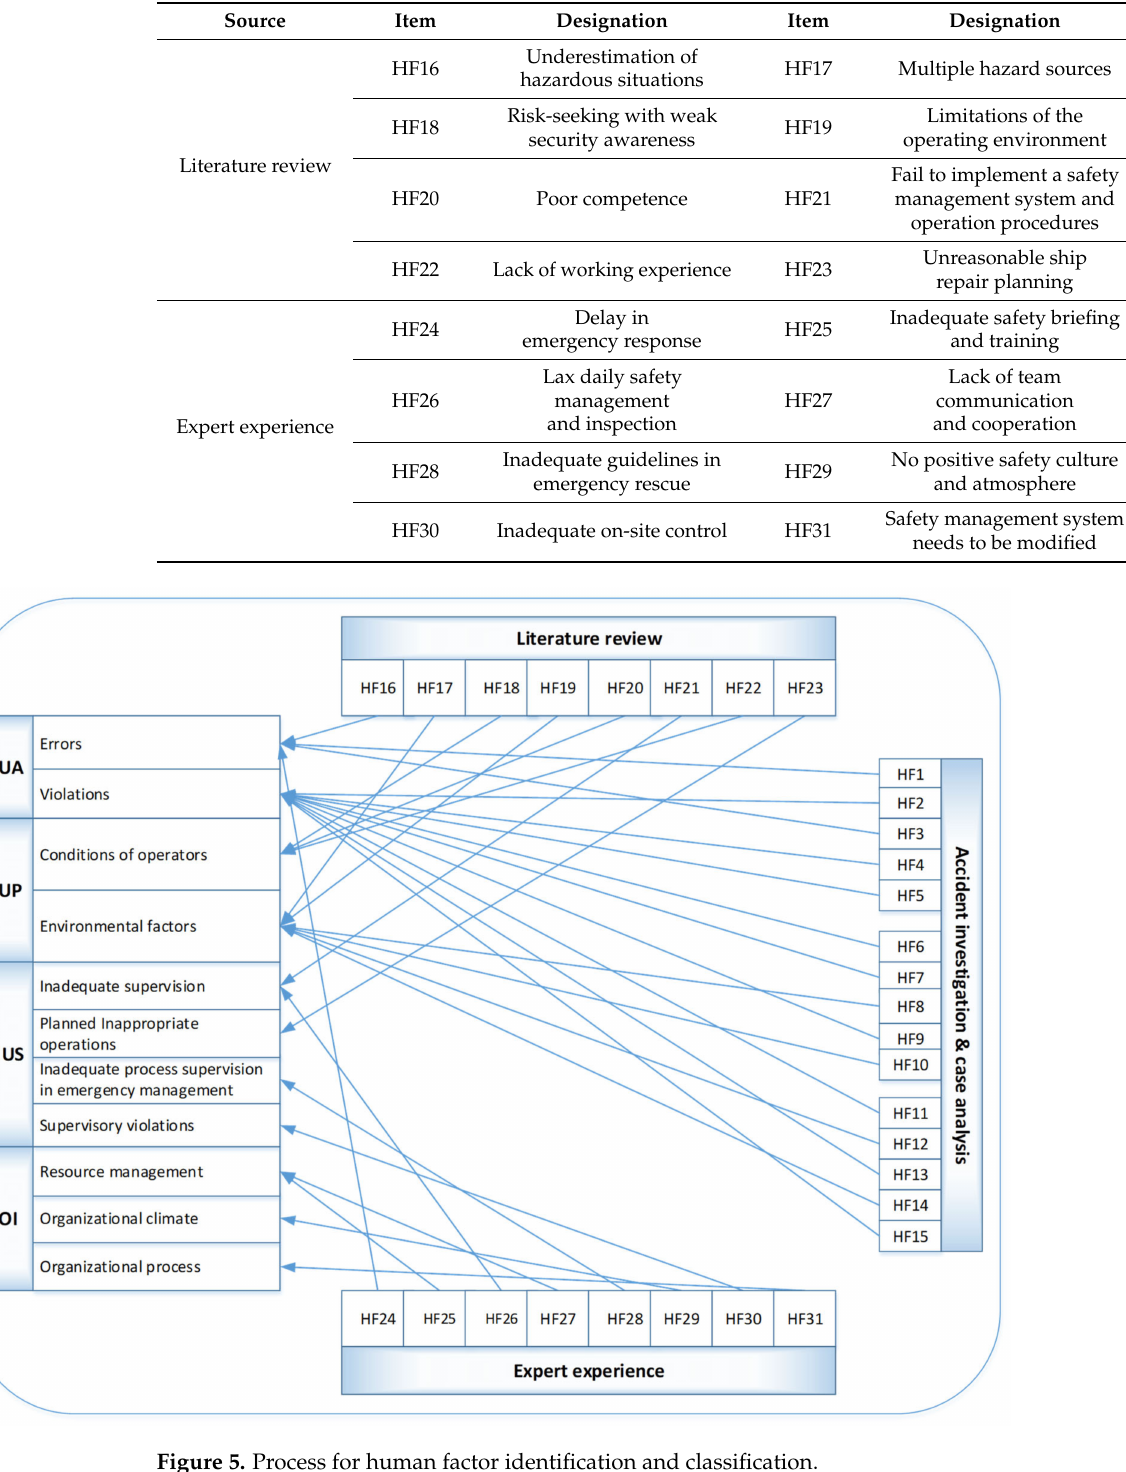
Figure 5. Process for human factor identification and